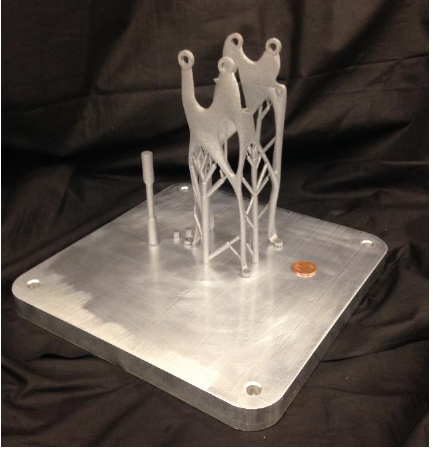
Figure 11. Real component made by SLM (small series).